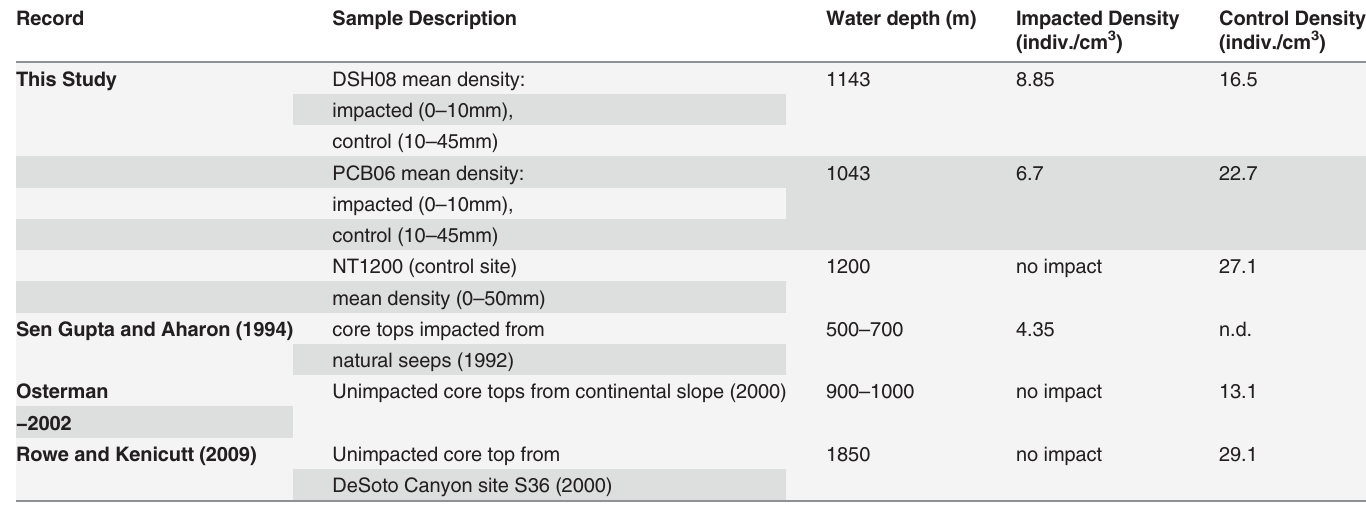
Table 3. Mean impacted and control benthic foraminiferal densities (indiv./cm − 3 ) from this study are presented with three previous records of total surface benthic foraminiferal densities (indiv./cm − 3 ) collected at natural seep sites and along the continental slope of the northern Gulf of